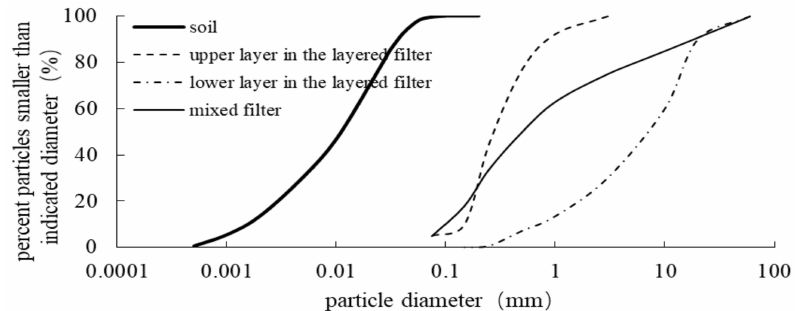
Figure 2. Distribution of soil particle size and sand-gravel size in di ff erent filter.